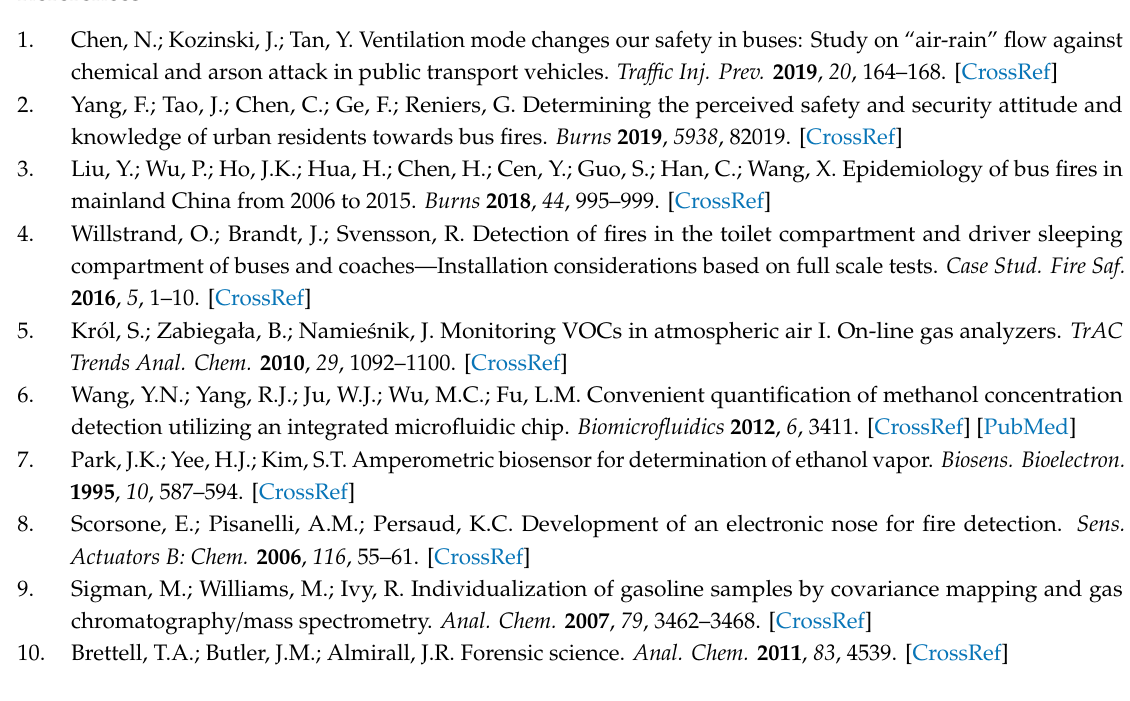
Figure S1: The odor data map (ODM) of ethanol, Figure S2. The odor data map (ODM) of lacquer thinner, Figure S3. The odor data map (ODM) of gasoline, Table S1. back propagation artificial neural network (BP-ANN) output layer of 75 test